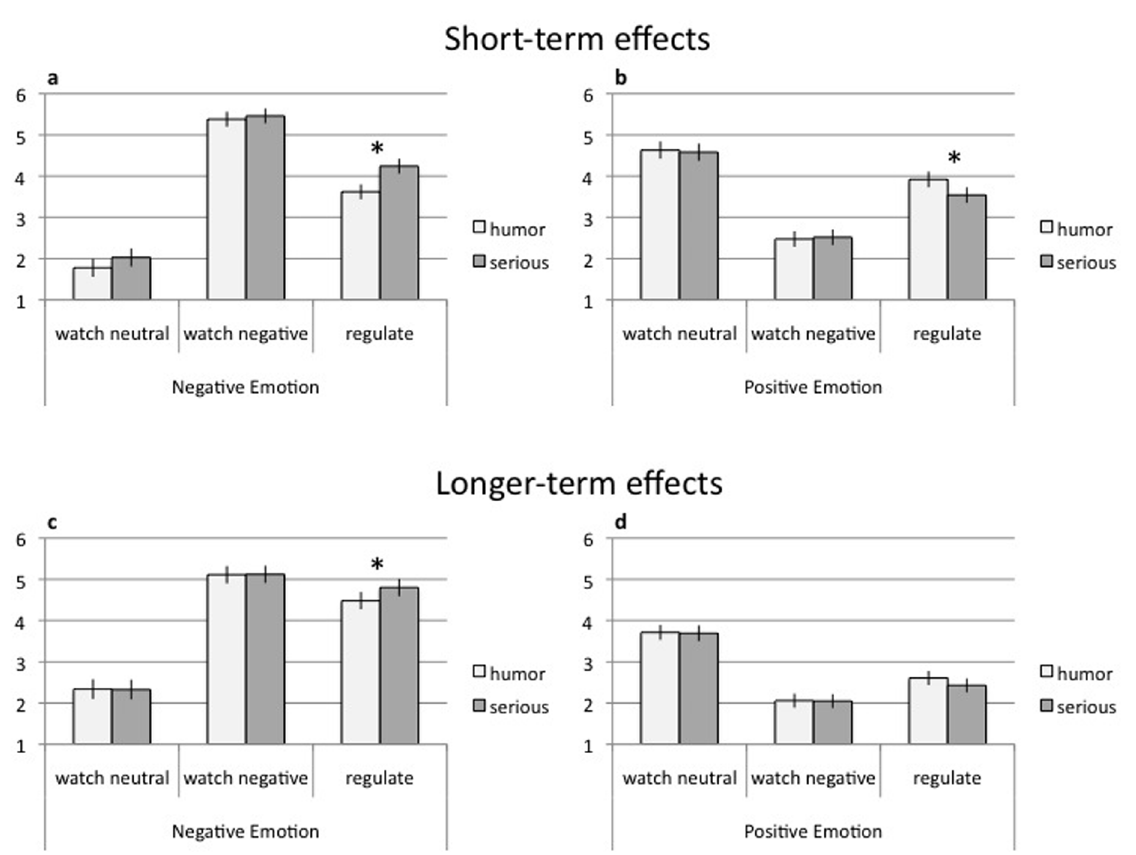
Figure 1. Short-term and longer-term emotional effects of humorous coping and serious reappraisal. Note. Means of positive and negative emotions by block type (humorous coping and serious reappraisal) and condition (watch neutral, watch negative, regulate); short-term effects on a) negative emotion and b) positive emotion, longer-term effects on c) negative emotion and d) positive emotion. * p <